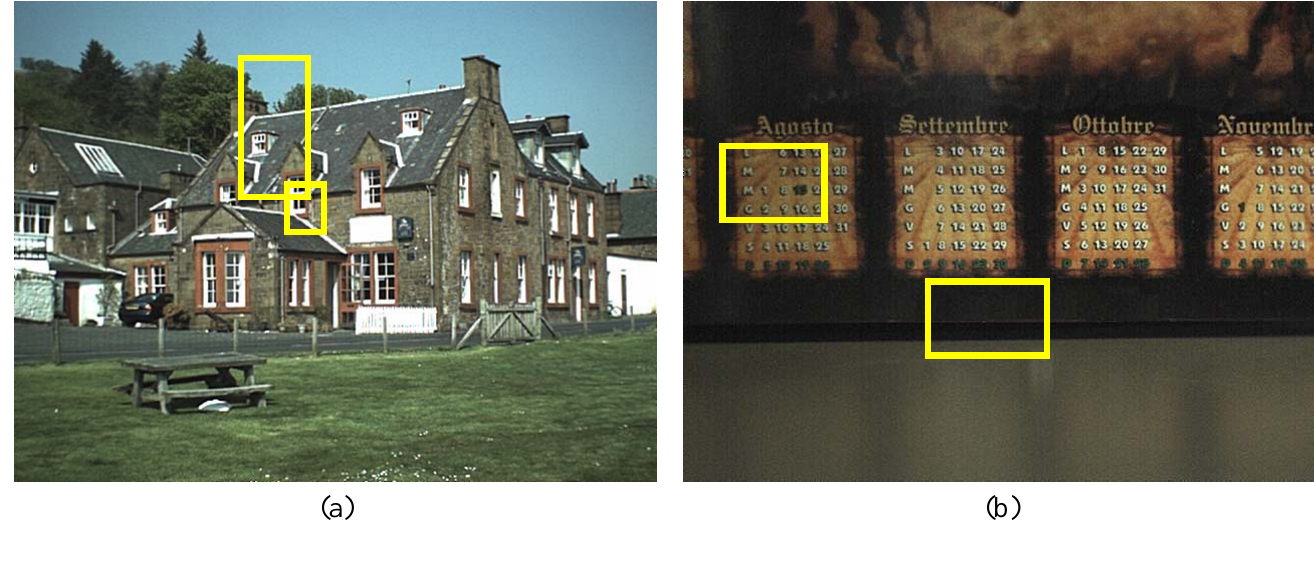
Figure 14. Images acquired by a CFA sensor. (a) SNR value 30.2dB. (b)SNR value 47.2dB. The yellow crops represent the magnified details contained in the following